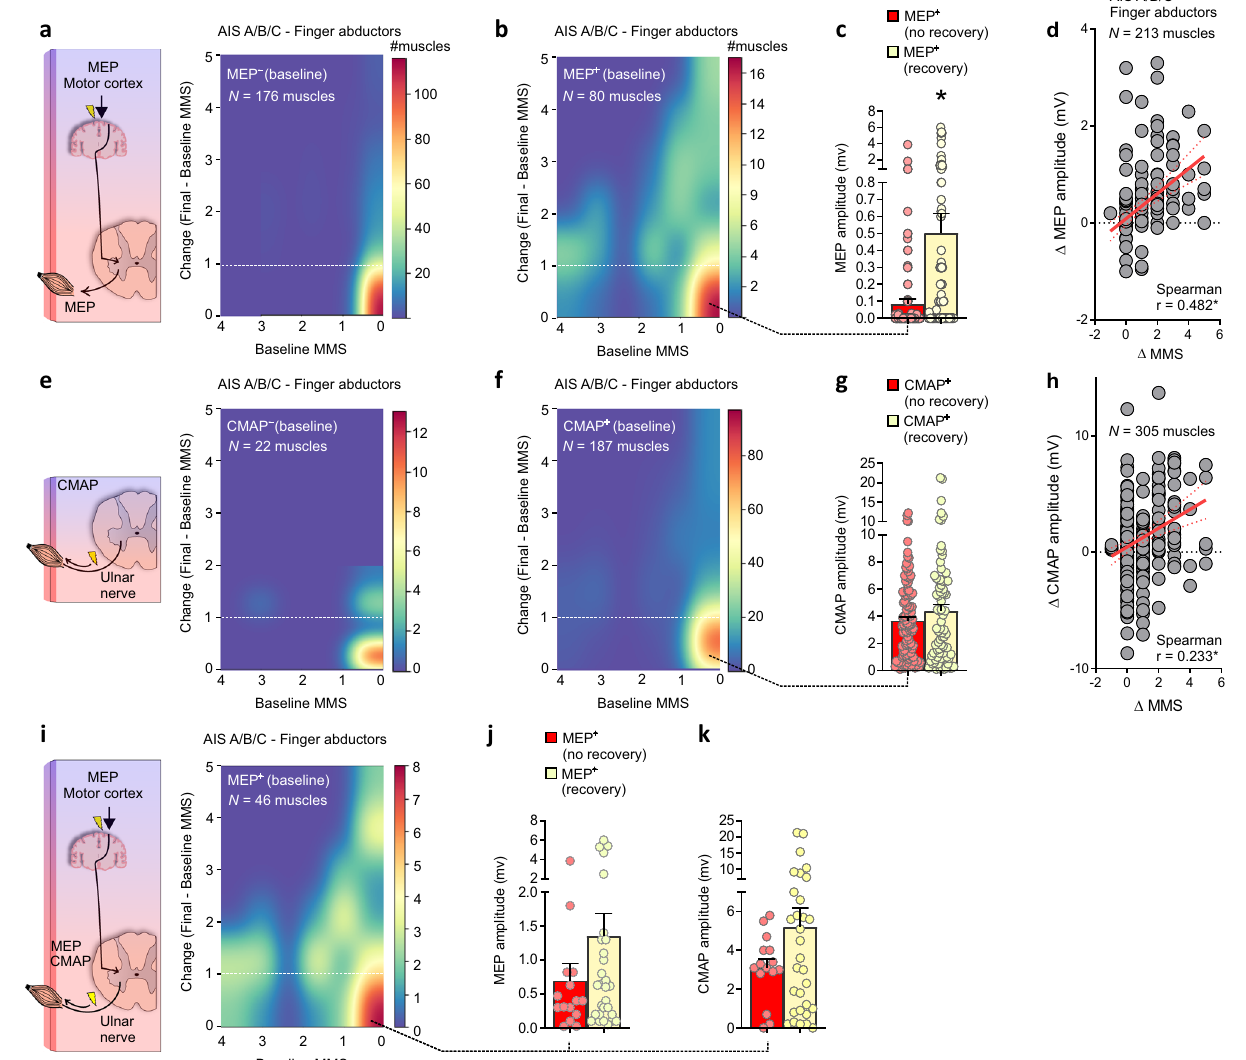
Fig. 7 | Corticospinal tract (CST) and LMN integrity in the abductor digiti minimi muscle. a In AIS A/B/C, fi nger abductor muscles with an MEP − display limitedmotorrecovery1-yearafterSCIcomparedto( b )muscleswiththepresence of an MEP (MEP + ) (yellow, above the hashed white line), including muscles with absentMMSatbaseline(rightmostpartoftheheatmap). c Thebinaryclassi fi cation of MEP + muscles that shows strength recovery or not was used to cluster the baseline MEP amplitude. This analysis indicates that higher MEP amplitudes were associated with increased strength recovery( p <0.0001). d The strength recovery of fi ngerabductors( Δ MMS)isaccompaniedbychangesinMEP amplitude( Δ MEP amplitude) throughout the natural recovery process. e – h Conversely to MEP, the presenceofCMAPatbaselineisnotstronglyassociatedwithmotorrecoveryofthe fi nger abductor muscles 1-year post-SCI in AIS A/B/C. i – k In a subgroup of